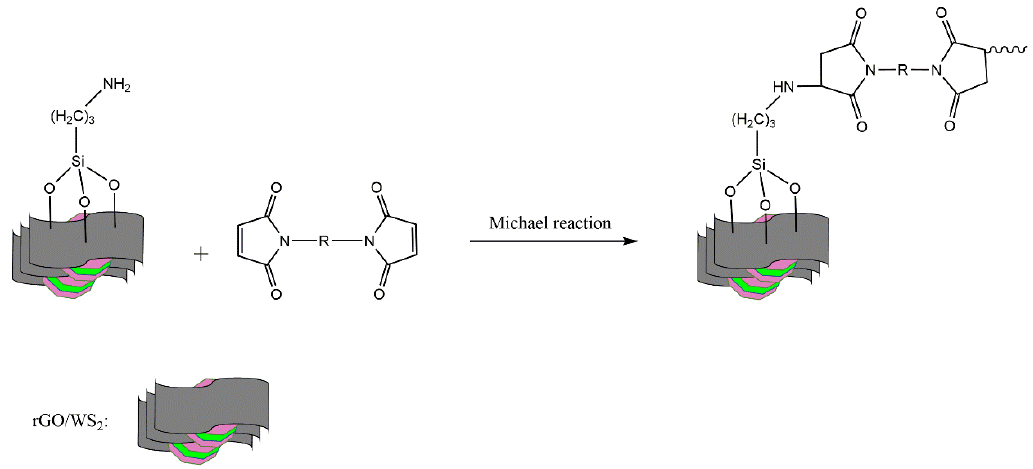
Scheme 2. The mechanism of Michael reaction of the amino groups on the NH 2 -rGO/WS 2 particles to maleimide groups.